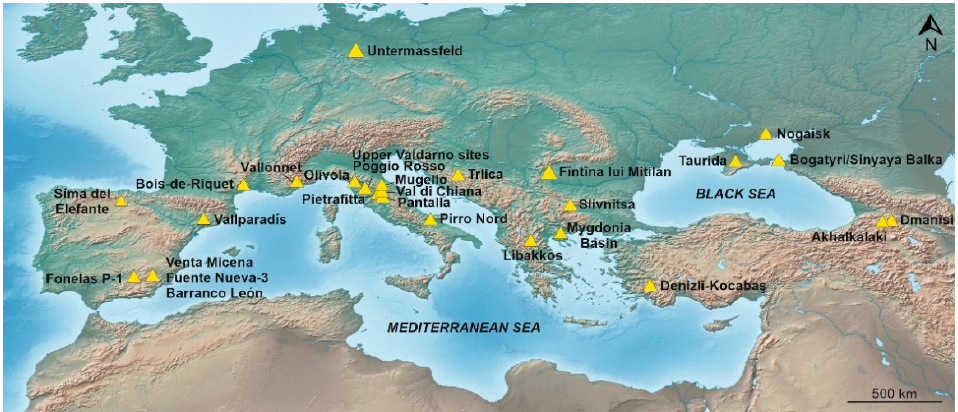
Figure 1. Selected sites of the Caucasus, the northern peri-Black Sea territory, and the northern peri-Mediterranean region, attributed to the late Villafranchian and Epivillafranchian, ~2.0–0.8 Ma (map from Natural Earth, naturalearthdata.com).